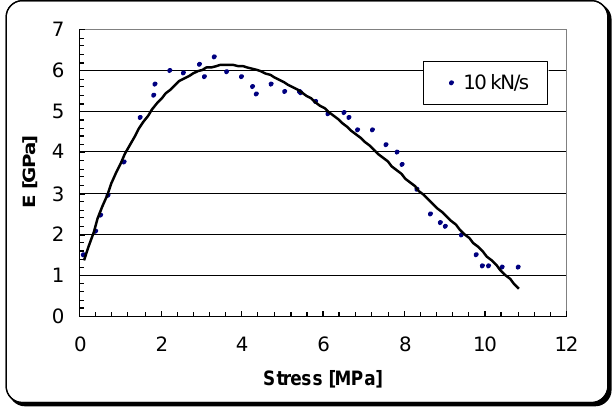
Figure 6. Tensile modulus elasticity of the DPT transducer [P-876 DuraAct™ (P-876.A11)] as a function of tensile force.